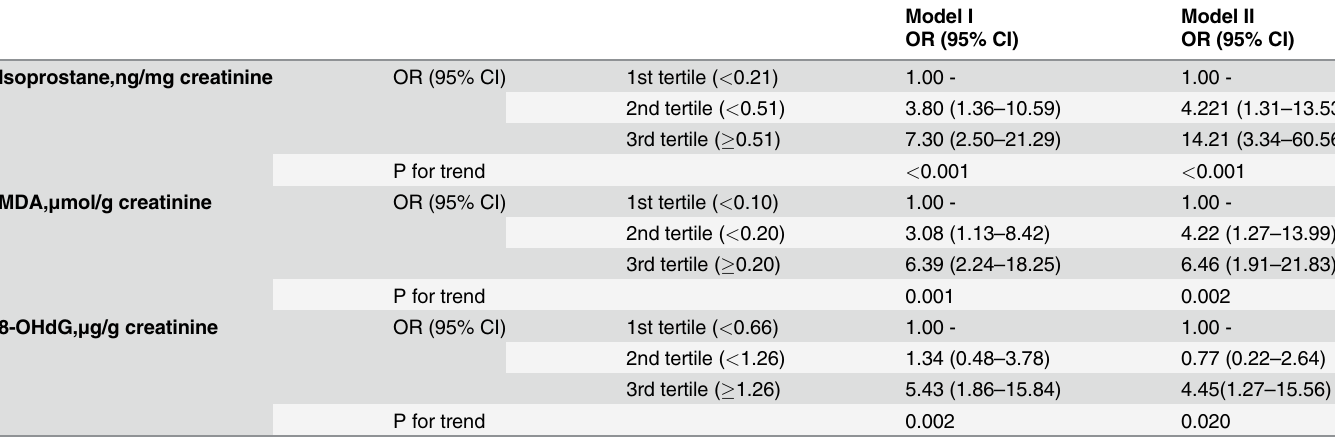
Table 2. Relationship between oxidative damage marker and carotid artery intima media thickness (mm).